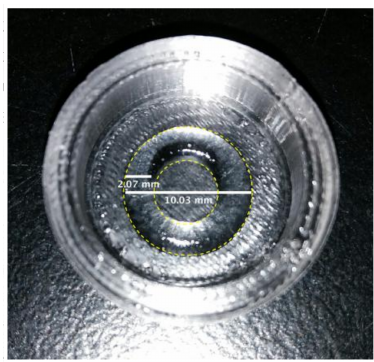
Figure 5. Representative printed ring in MC-Na005 hydrogel in the M12 support. The inner and outer diameters are shown by dotted